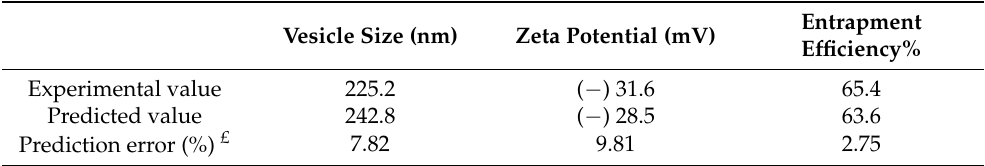
Table 3. The values of experimental, predicted and prediction error of the optimized GS-CBS formulation dependent variables.